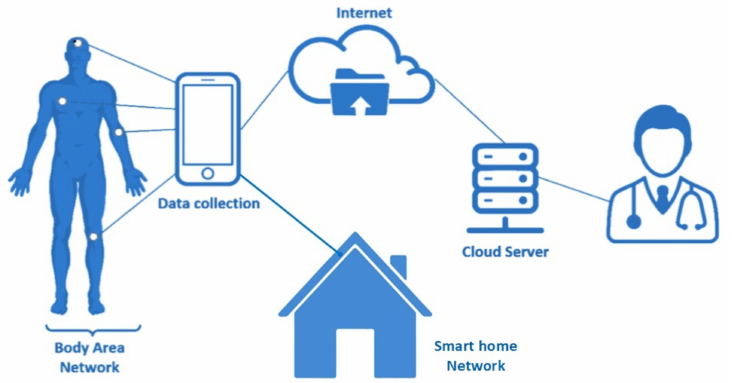
Figure 1. Smart home network merged with a healthcare Internet of Health Things (IoHT) network